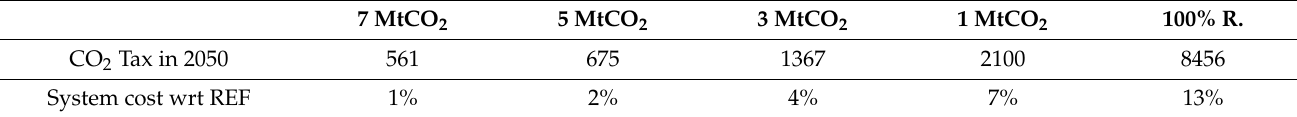
Figure 9. Capacity and generation in 2050 for each emissions scenario. Table 4. CO 2 taxes in USD/CO 2 and total system cost increase wrt REF